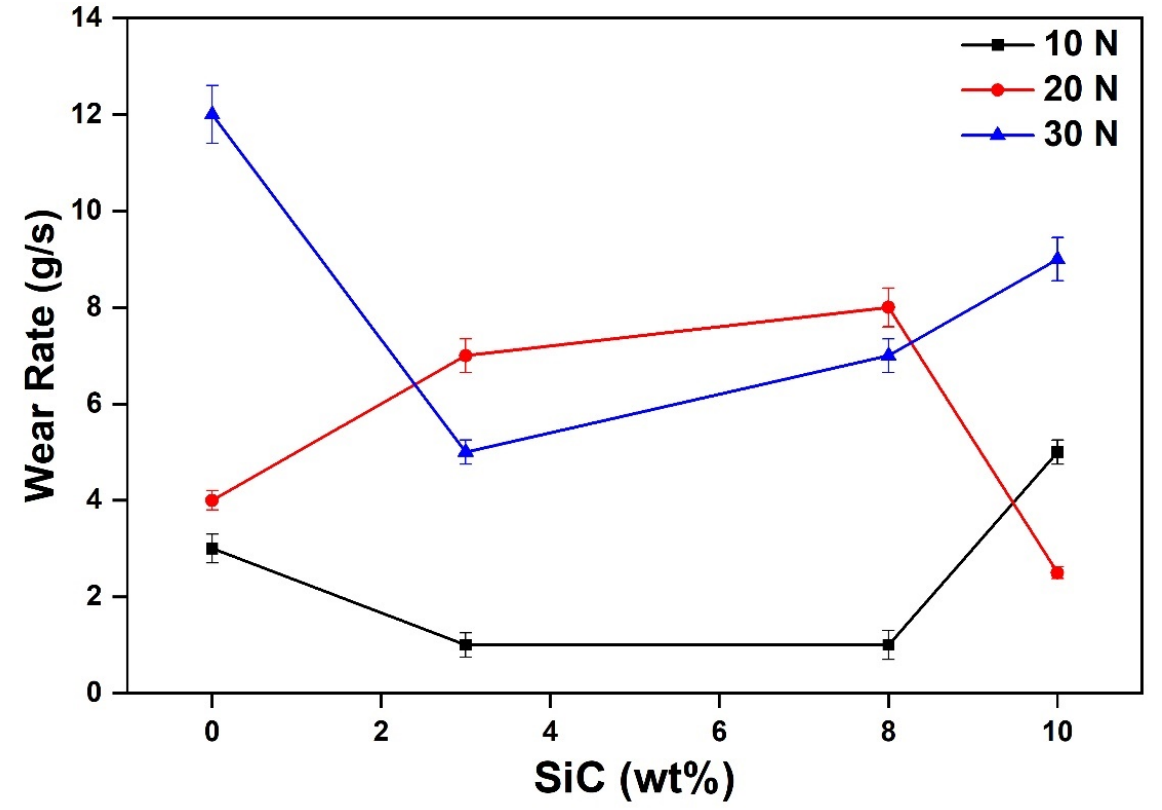
Figure 8. Variation of wear rate of Al-MMCs with SiC content at different load and constant velocity of 1 m/s.